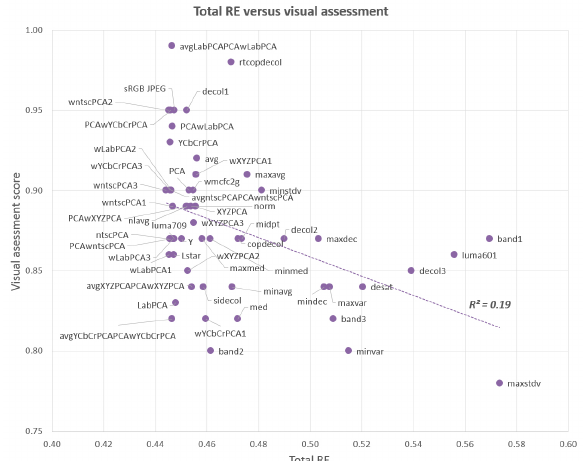
Figure 5. Total RE (PSFE) versus a visual assessment score, averaged over all image